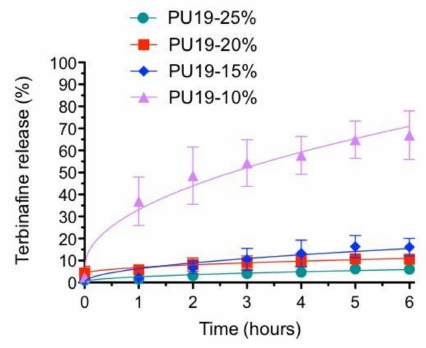
Figure 1. Release of TH from different formulations at 32 ◦ C (mean ± SD, n =